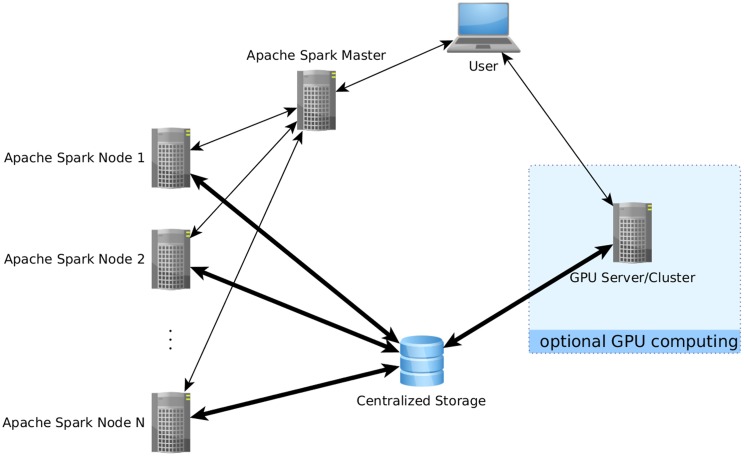
Data flow using the proposed analysis methods. Bold arrows represent intensive data flow, the other arrows represent communication of control commands. In this example, parts of the computations have been performed on a separate GPU computing server which was not part of the Apache Spark cluster. The use of a centralized data storage facilitates the integration of all steps into a comprehensive pipeline, as the fMRI data is loaded directly from there onto the GPU server, who then writes the results as edgelist back on the storage to be directly readable by Apache Spark. Note that storing data directly on the compute nodes is also possible as an alternative if issues related to data transfer speed are encountered.